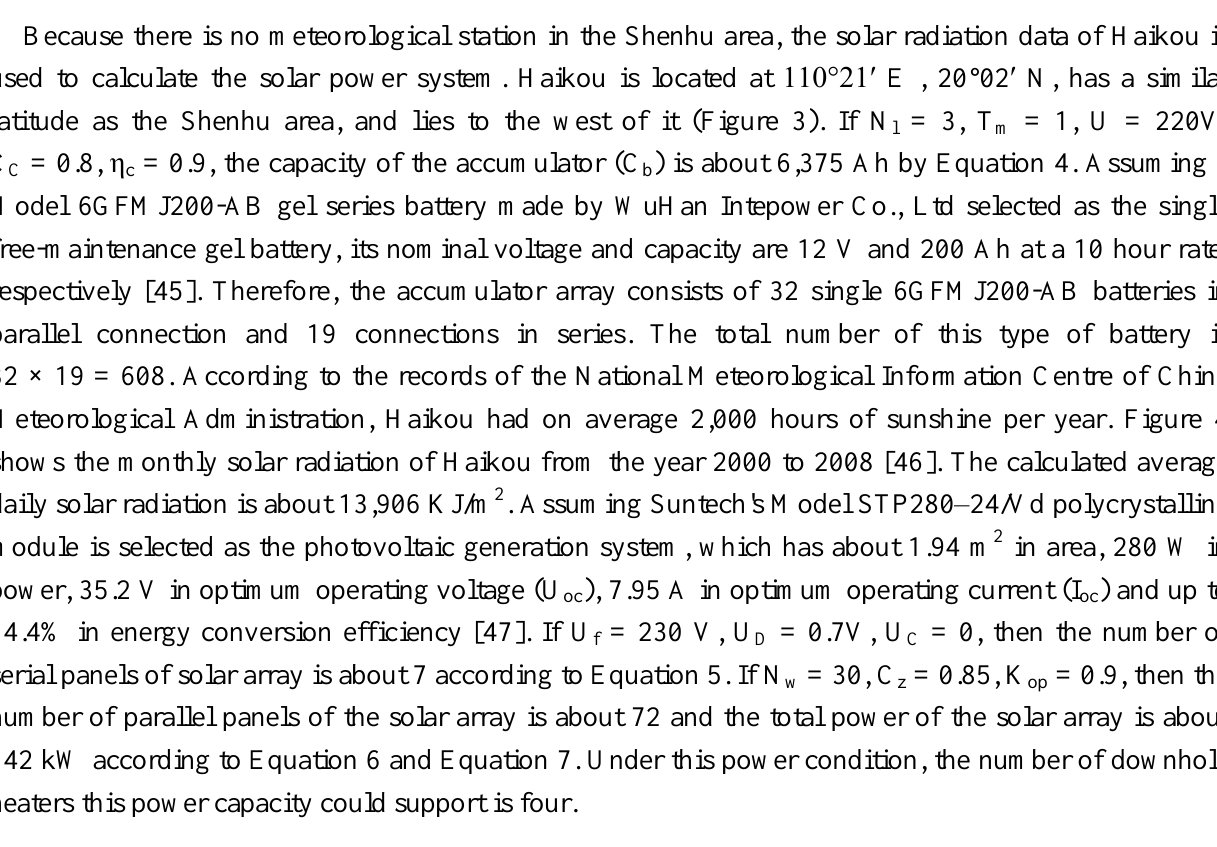
Figure 4. Monthly solar radiation of Haikou from year 2000 to